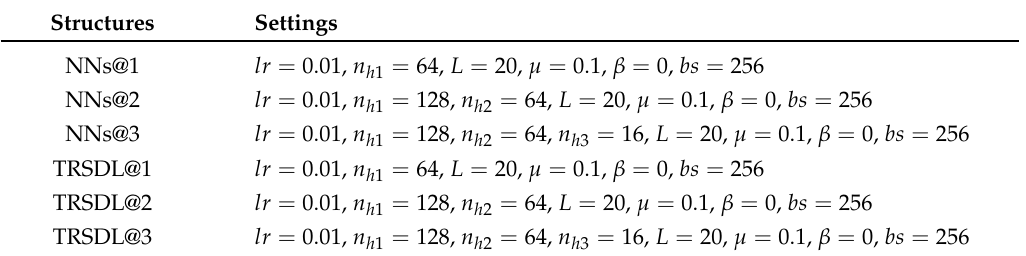
Table 3. Parameters of various model structures.